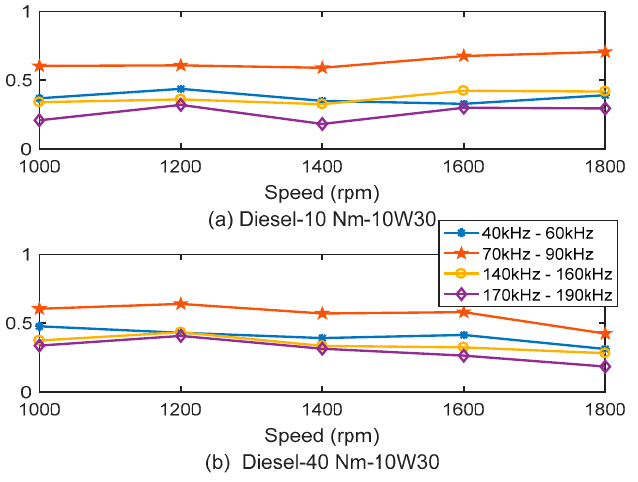
Figure 9. The correlation coefficients of four selected bands with the baseline diesel-10W30: ( a ) Diesel with 10W30 under 10 Nm; ( b ) Diesel with 10W30 under 40 Nm.